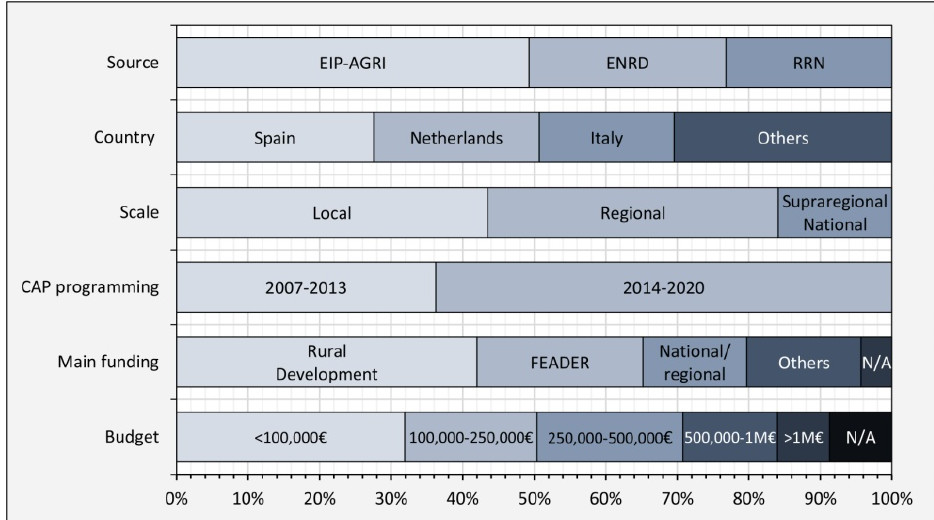
Figure 4. Analytical approaches used in the selected case studies (%).